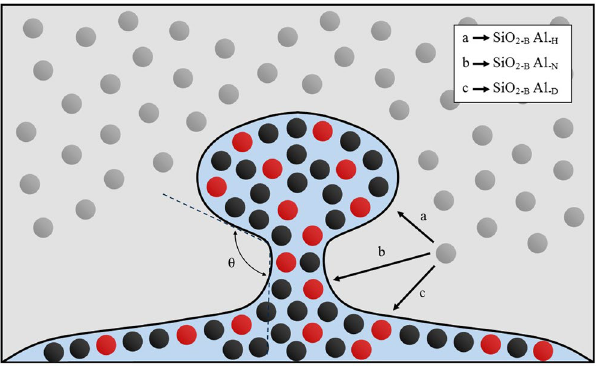
Figure 10. A schematic of the interface between an iron aluminium metal alloy (black particles represent iron atoms, red particles represent aluminium atoms) and a metal oxide medium (specifically silica molecules, grey particles). An example of perturbation growth and necking is given with varying diffusion distances of